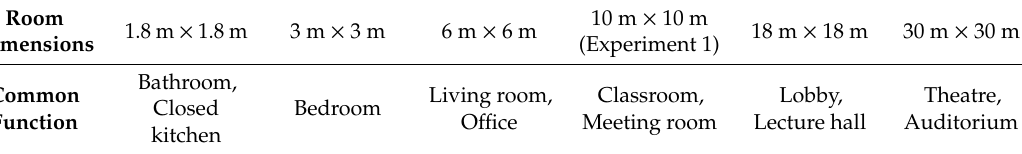
Table 2. Tested virtual rooms: dimensions and common